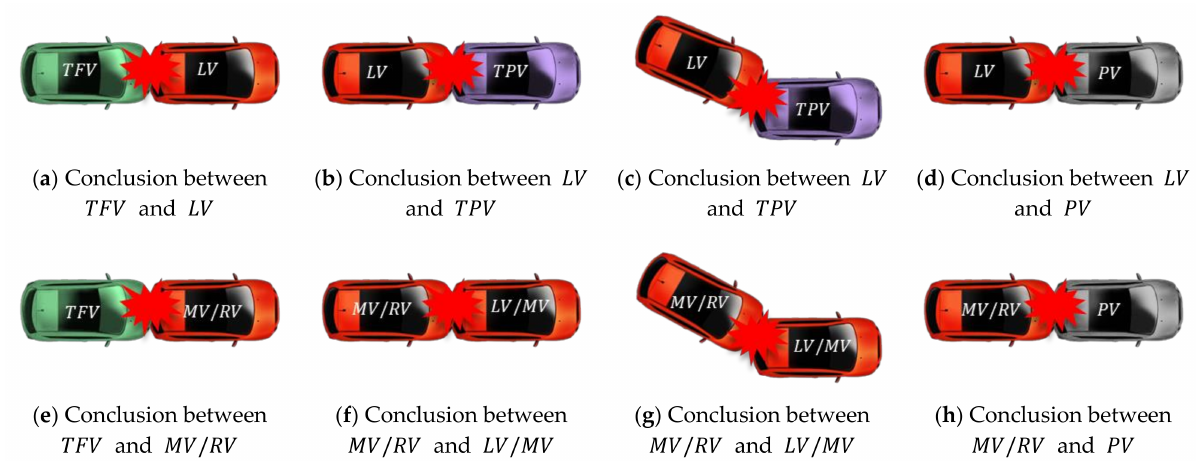
Figure 2. Eight types of crash accidents in the platoon-lane-changing